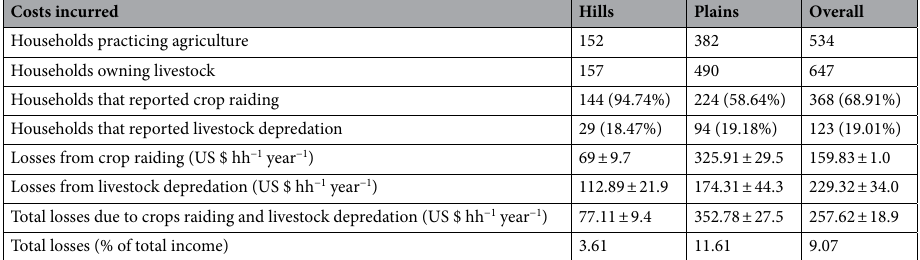
Table 3. Cost incurred due to wildlife around the forest corridor linking the Rajaji and Corbett Tiger Reserves, Uttarakhand, India. (* values in parentheses indicate percentage of total households sampled)